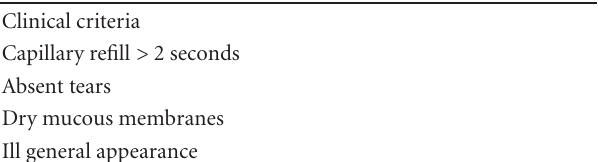
Table 3: The Gorelick